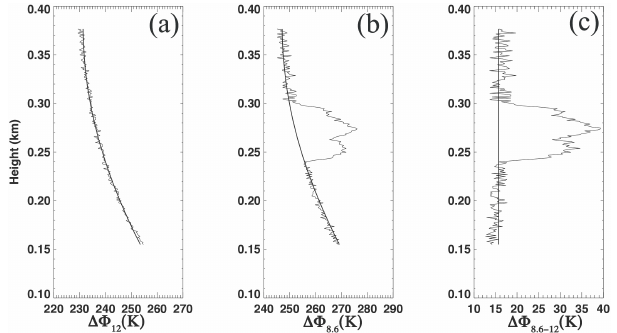
Figure 13. (a) Brightness temperature versus height variation for the 12µm filter ( 8 12 ) (b) As for (a) but for the 8.6µm filter ( 8 8 . 6 ). (c) The 8.6–12µm brightness temperature difference ( 18 8 . 6 , 12 ). The curved lines are least-squares second-degree polynomial fits based on profile data above the plume, and extrapolated through and below the plume.